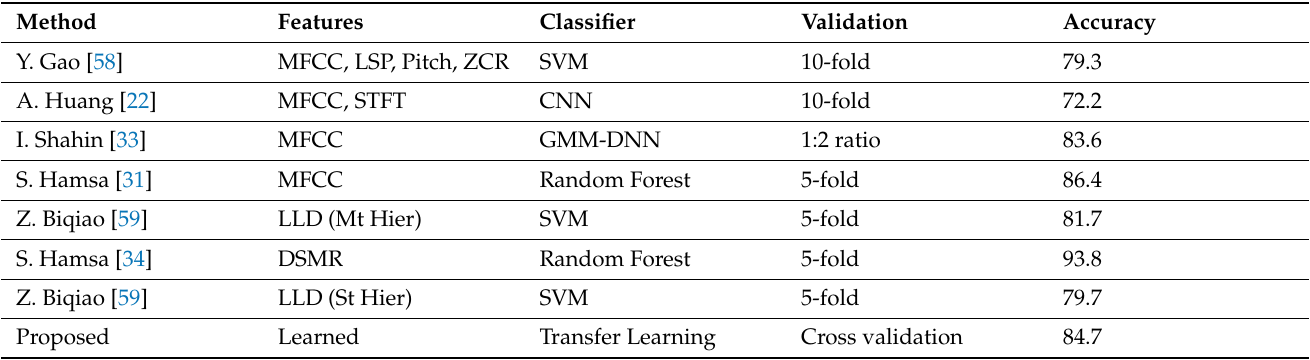
Table 3. Performance study of various methods employing the RAVDESS